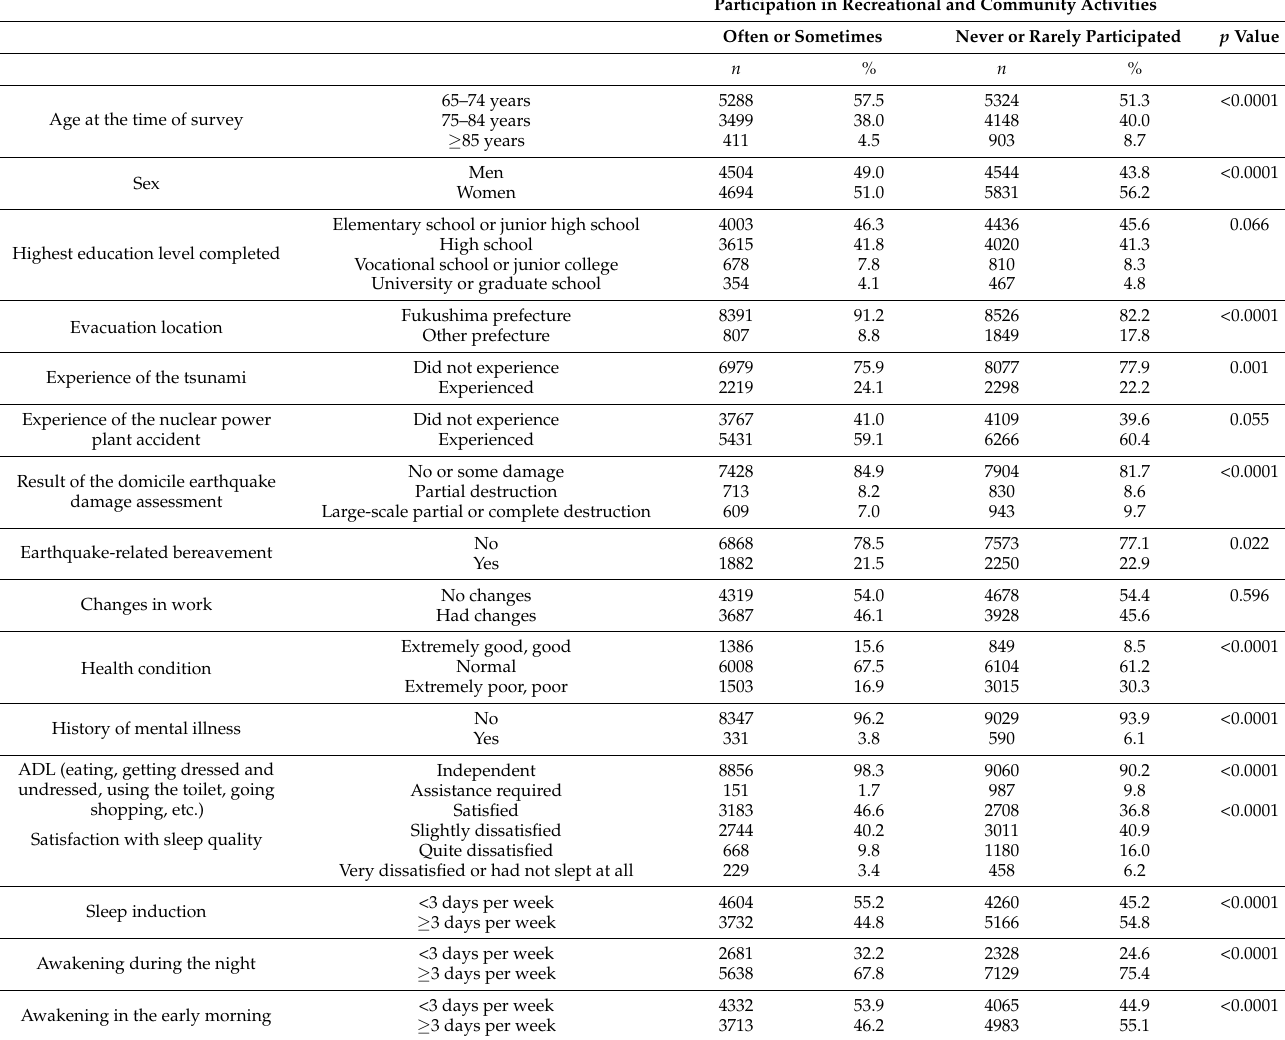
Table 1. Participants’ basic characteristics, disaster-related items, and physical and mental health by frequency of social par-